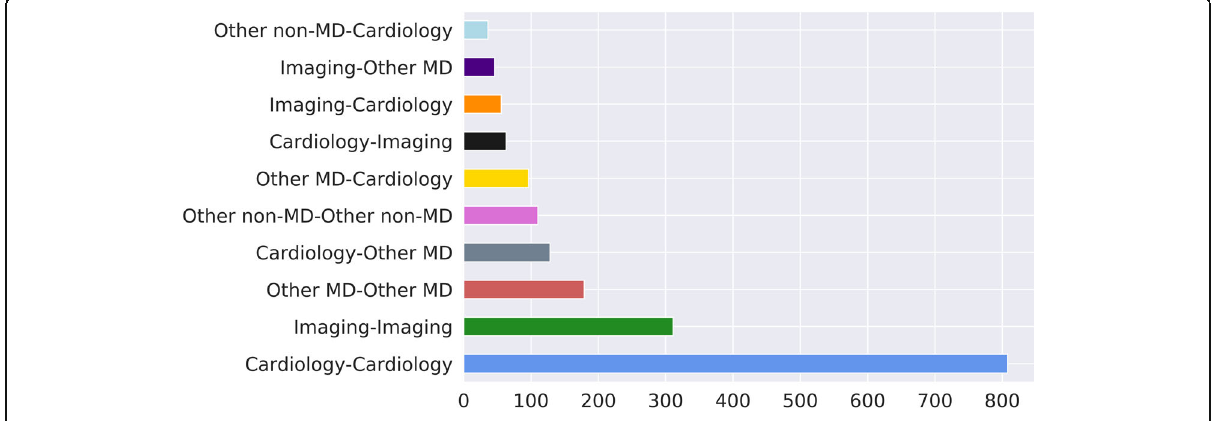
Fig. 4 Bar plot showing the total number of studies grouped by the ten most frequent first and last author category